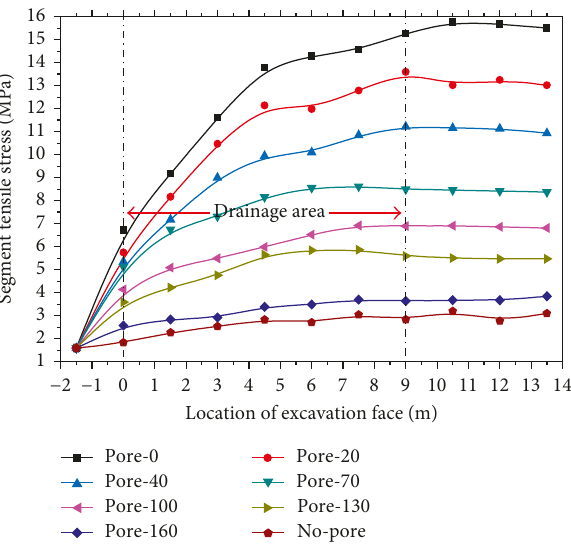
Figure 15: Maximum tensile stress at